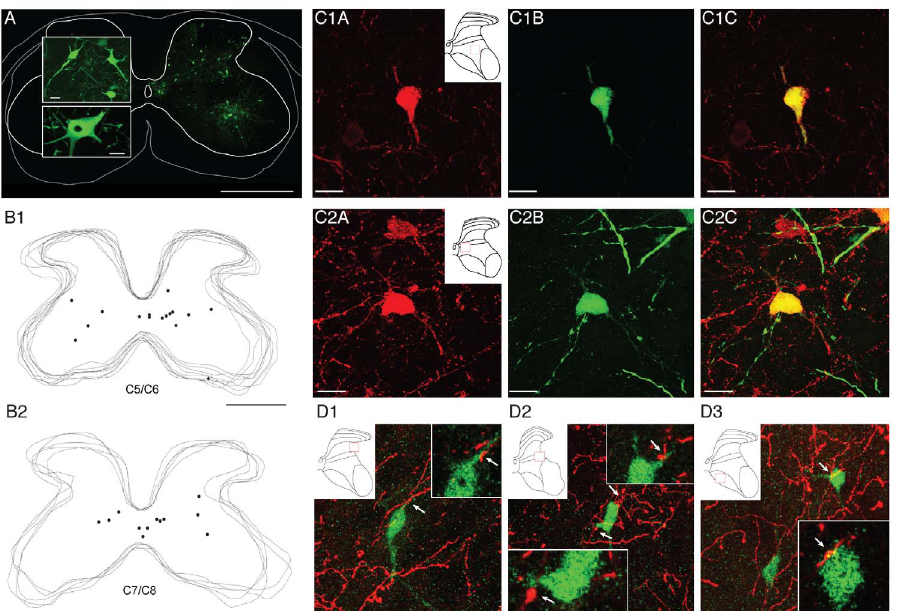
Figure 7. Spinal labeling of last-order (premotor) interneurons with PRV, co-labeling with ChAT, and contacts with CSTs. (A) Example of labeling in one 40 m m section achieved at 64 hours after intramuscular PRV injection. Large panel shows labeling on ipsilateral side (Calibration: 500 m m). There was minimal contralateral labeling. Top inset shows an example of labeled interneurons (located in lamina 4 on the section shown), and lower panel, a motoneuron, at higher magnification (Calibration: 25 m m). (B1–B2) Overlaid section images for two representative animals processed in Neurolucida showing positions of individual last-order interneurons from PRV injected into the deltoids, biceps and wrist extensors at levels C5/C6 (B1) and C7/C8 (B2) that also label positively for ChAT. (C1–C2) Confocal images of two representative PRV-ChAT double-labeled interneurons at levels C7/C8 (C1) and C5/C6 (C2). ChAT=red; PRV=green. (D1–3) (D) Confocal images of PRV-labeled interneurons receiving contacts from BDA-labeled CST axons terminals. PRV was injected into the biceps and wrist extensor compartments. Each panel shows a projection image (center, large image) and representative 1 m m optical slices (insets). Arrows show sites of contact,. Scale bars for A, large panel=500 m m, smaller panels=50 m m; B, same as A; C and D=20 m